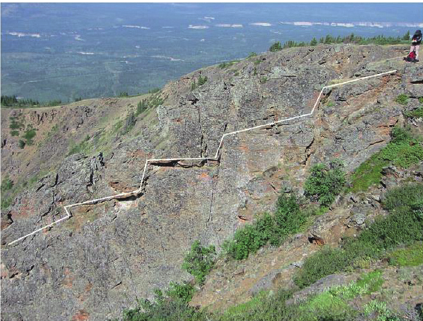
Figure 1: An undulate surface at the Aishihik River Landslide in Canada [3].